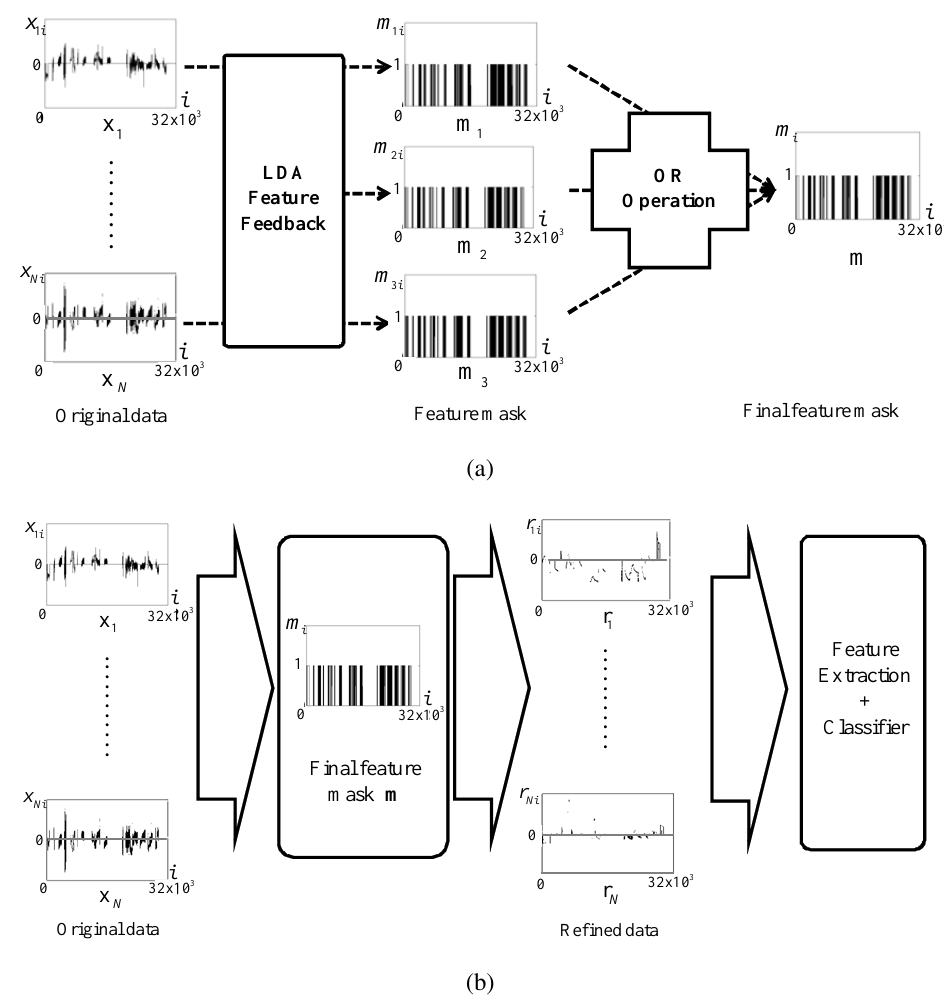
Figure 2. The procedure of the overall data refinement and vapor classification. (a) Feature feedback to obtain the final feature mask; (b) Vapor classification based on the data